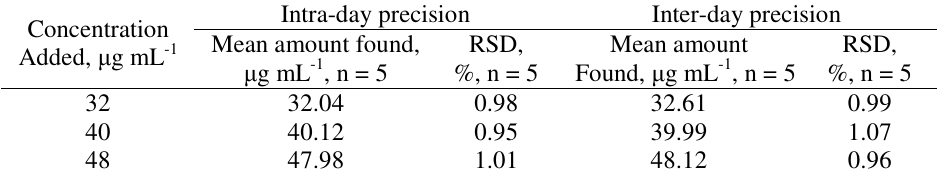
Table 2. Intra-day and inter-day precision of the method.